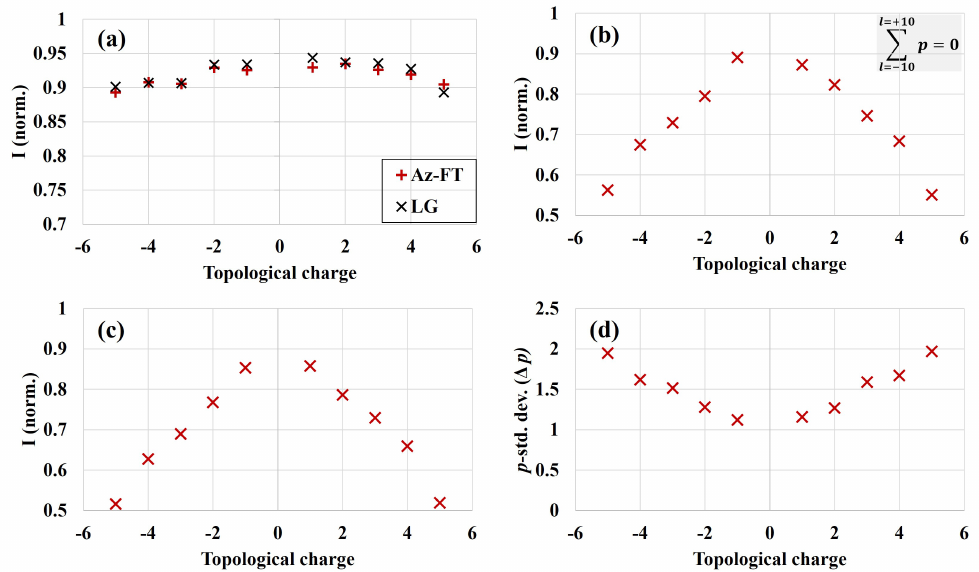
Figure 6. Modal analysis for the vortex beams of topological charge (cid:96) = − 5 to + 5. ( a ) Comparison of the OAM purity obtained via azimuthal Fourier transform and LG decomposition. ( b ) The energy contained in p = 0 radial mode summed over (cid:96) = − 10 to (cid:96) = + 10. ( c ) Contribution to LG (cid:96) = (cid:96) , p = 0 mode. ( d ) The standard deviation of p -spectrum ( ∆ p ). The increasing trend of ( ∆ p ) with topological charge signifies a broader p